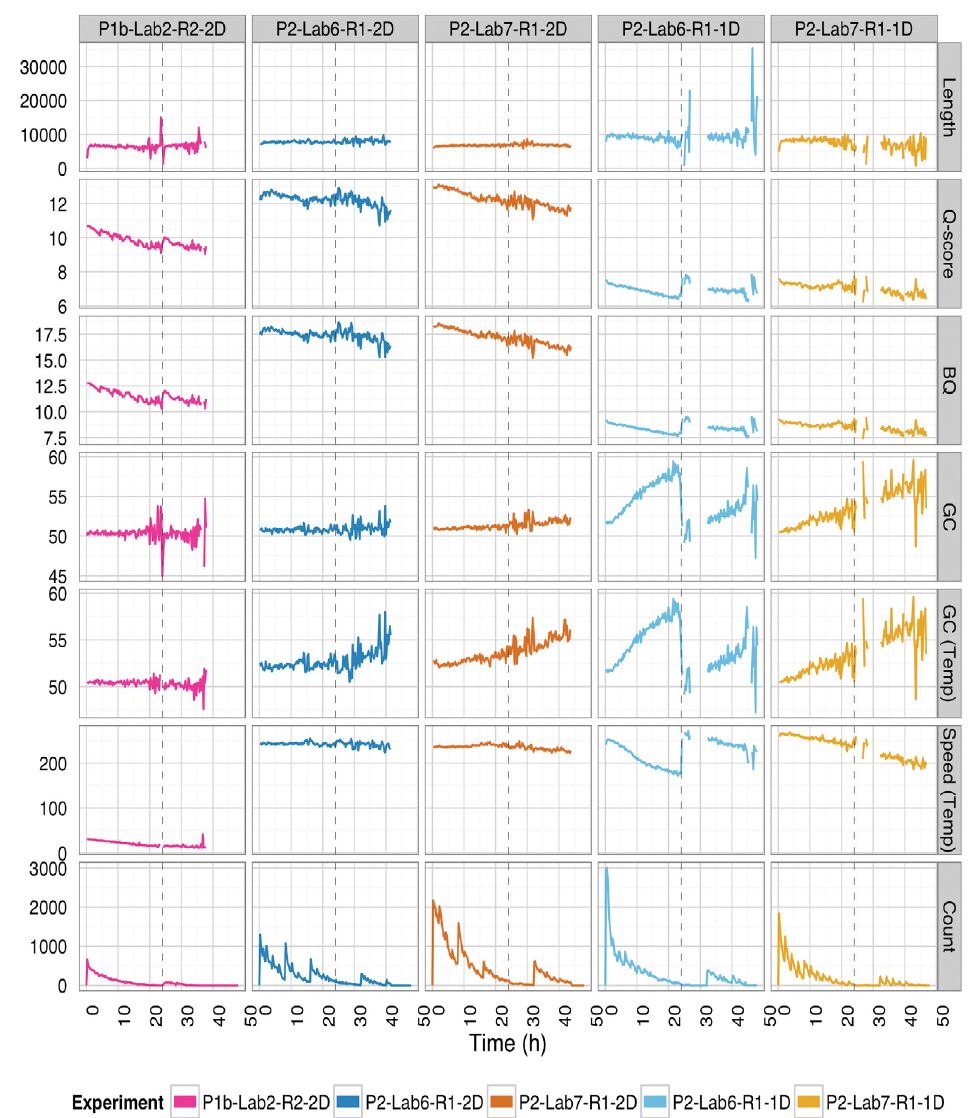
Figure 2. Sequencing performance over time. The mean read length (kb), Q-score, base quality (BQ), and GC%, speed (bases per second), and throughput (count) for each experiment, computed from “pass” reads that mapped to the E. coli reference, were plotted for 15 minute intervals. The values for template reads (“1D”) are plotted for the 1D libraries (P2-Lab6-R1-1D and P2-Lab7-R1-1D) whereas the values for 2D reads were plotted for the 2D libraries (P1b-Lab2-R2-2D, P2-Lab6-R1-2D, and